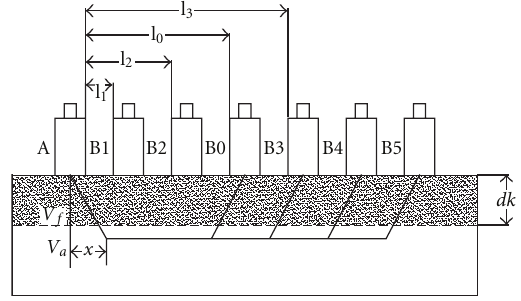
Figure 2: Layout of the transducer.